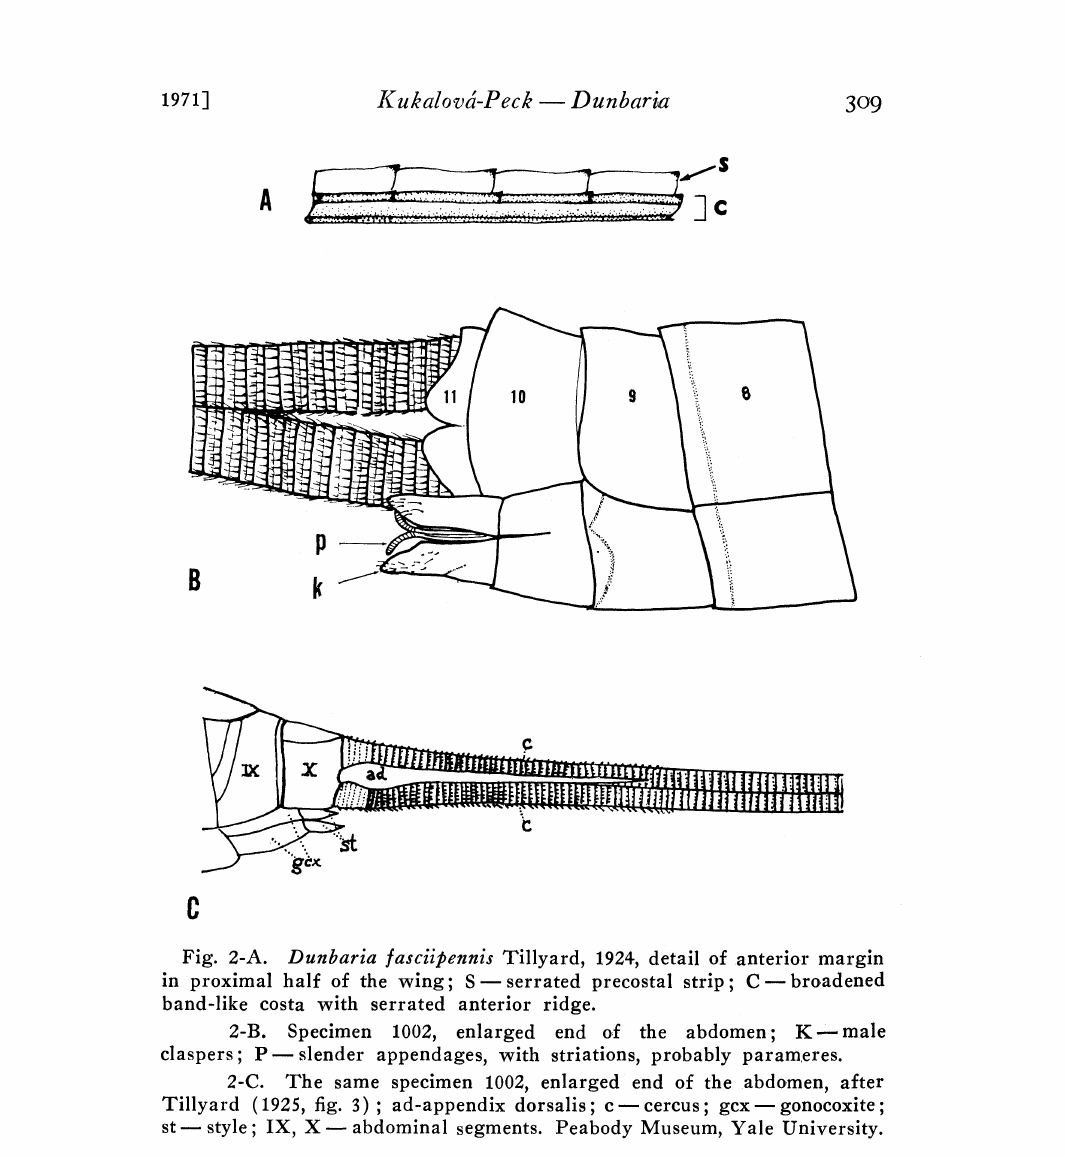
Fig. 2-A. Dunbaria [asciil.ennis Tillyard, 1924, detail of anterior margin in proximal half of the wing; S mserrated precostal strip; C mbroadened band-like costa with serrated anterior ridge. 2-B. Specimen 1002, enlarged end of the abdomen; K male claspers; P slender appendages, with striations, pro.bably parameres. cercus gcx gonocoxite st style; IX,